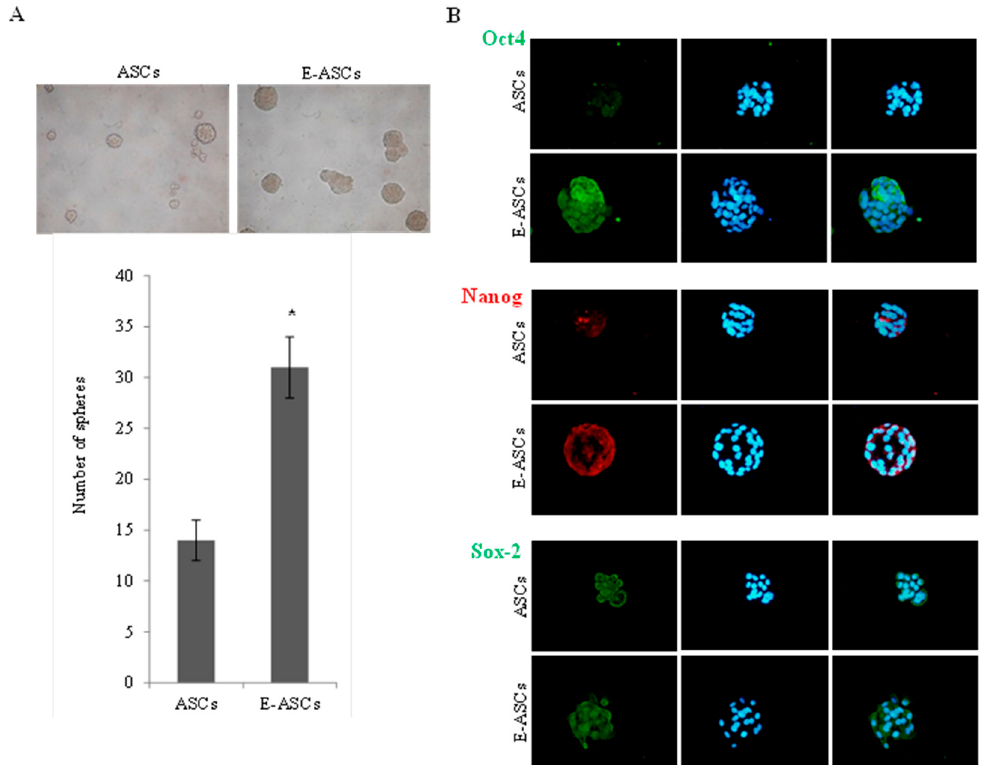
Figure 3. Effect of eugenol on the self-renewal characteristics of ASCs. ( A ) Representative photos for spheres formed after 21 days, magnification: ×40. The ability to form spheres was expressed by the number of the formed spheres. Bars represent mean ± SD. Significant difference is analyzed by a Student’s t -test, where: *: p < 0.001. ( B ) Immunofluorescence staining of the formed spheres using Oct4 , Nanog and Sox2 antibodies (left lane). Spheres were counterstained with Hoechst (middle lane) then merged (right lane), magnification: ×100. ASCs: adipose tissue-derived mesenchymal stem-like cells, E-ASCs: adipose tissue-derived mesenchymal stem-like cells pretreated with eugenol for 24 h, Oct4 : octamer-binding transcription factor 4.